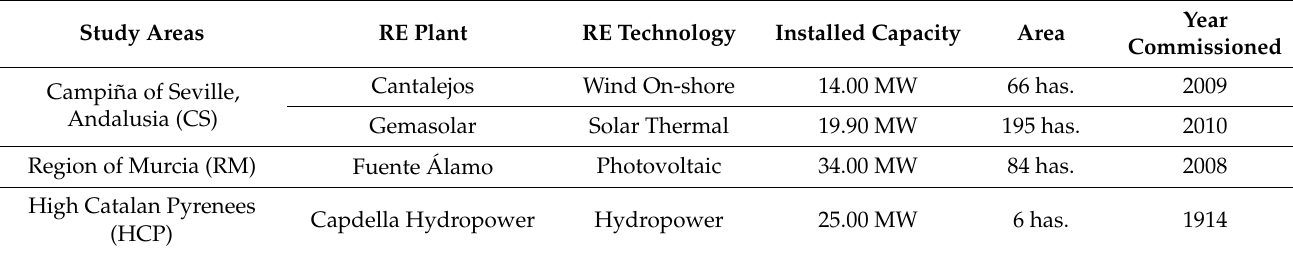
Table 1. Renewable energy plants